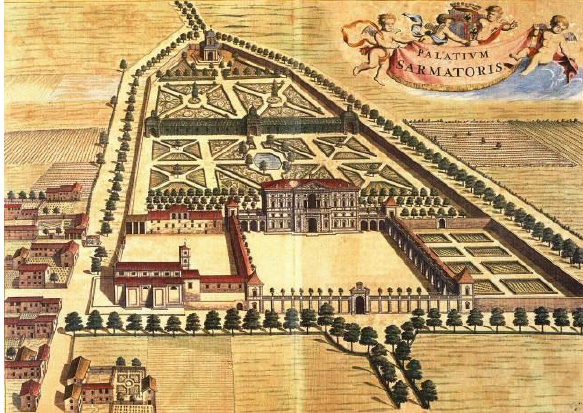
Figure 2. A view of the Palazzo Sarmatoris in the Theatrum Sabaudiae (Roccia, 2000).